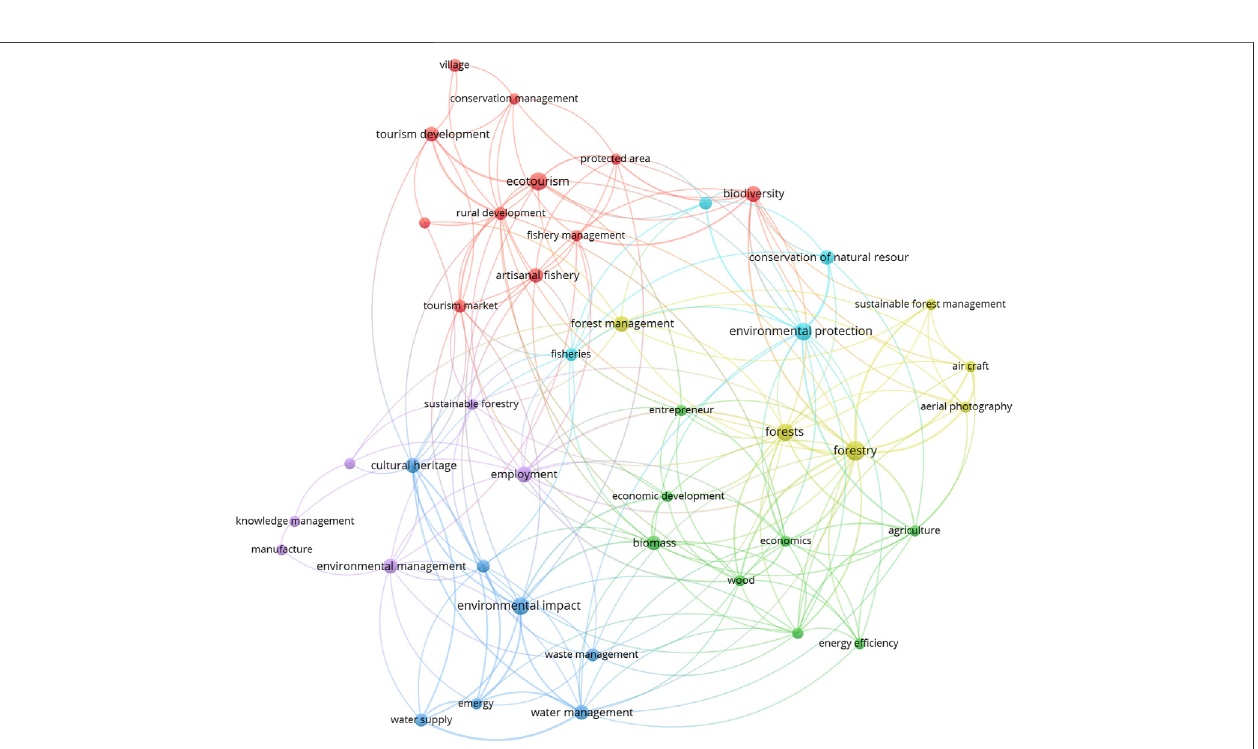
Frontiers in Environmental Science |